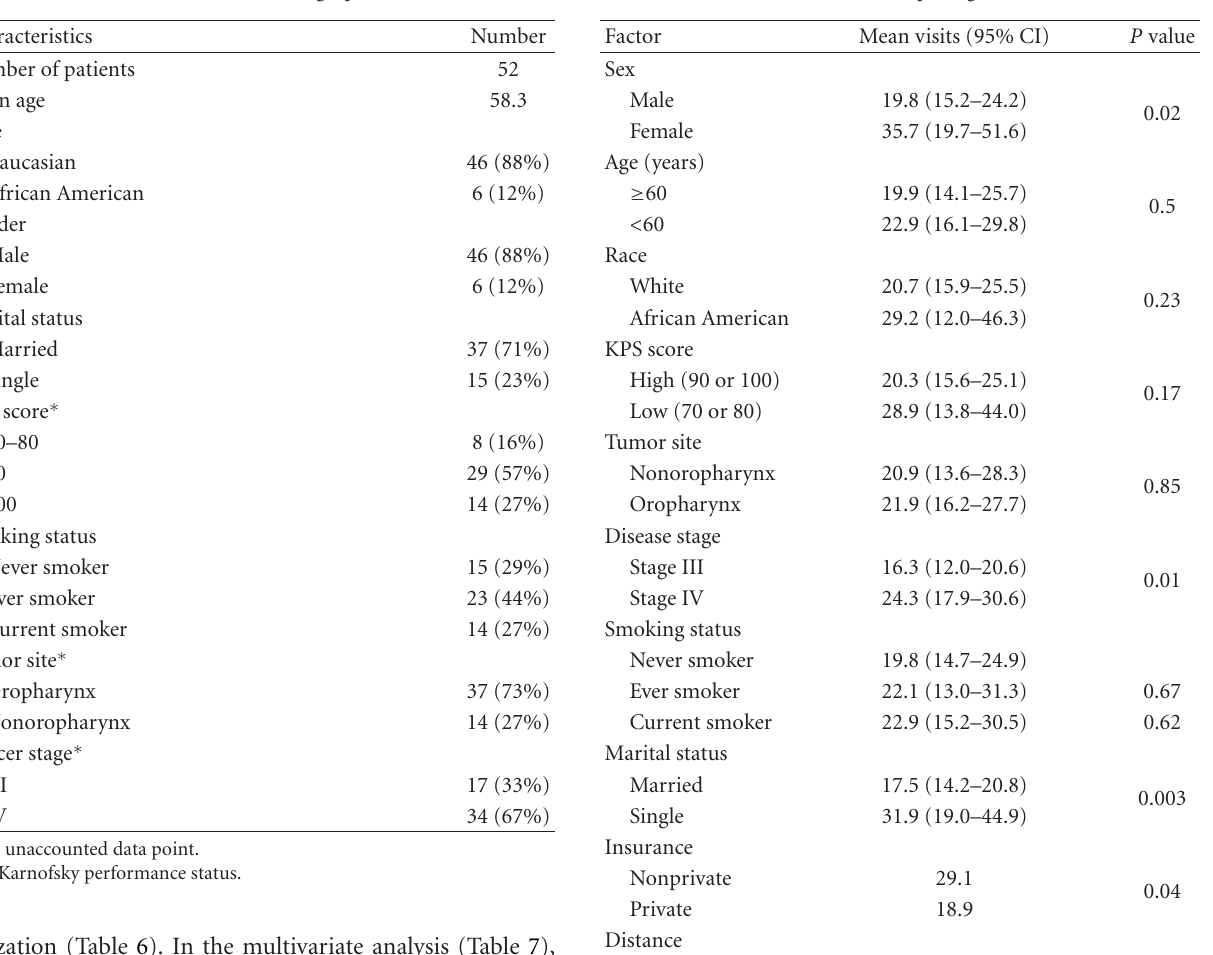
Table 1: Patient demographics. Table 2: Social work simple regression